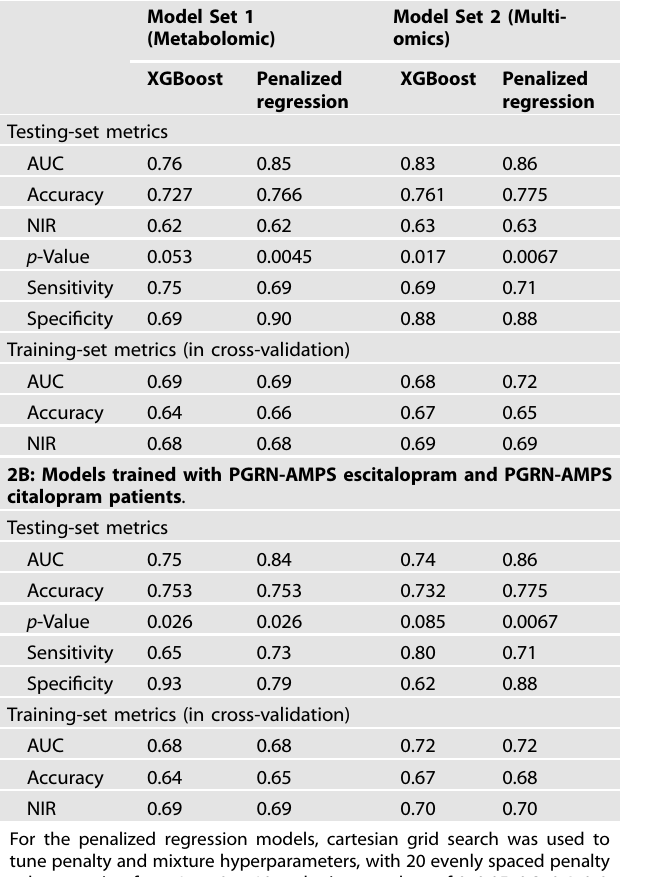
for both algorithms (Table 2B).